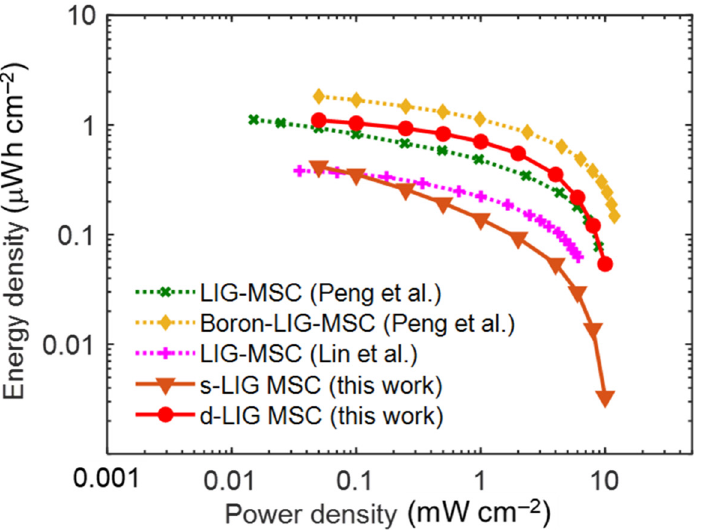
Figure 6. Ragone plot of s-LIG-MSC, d-LIG-MSC, and other LIG-based MSCs fabricated by using a CO 2 laser. Origin ® software (2019b, OriginLab Co., Northampton, MA, USA) was used to reproduce data reported in Ref. [27] (LIG-MSC, Peng et al.), Ref. [6] (LIG-MSC, Lin et al.), and Ref. [9] (Boron-LIG-MSC, Peng et al.).